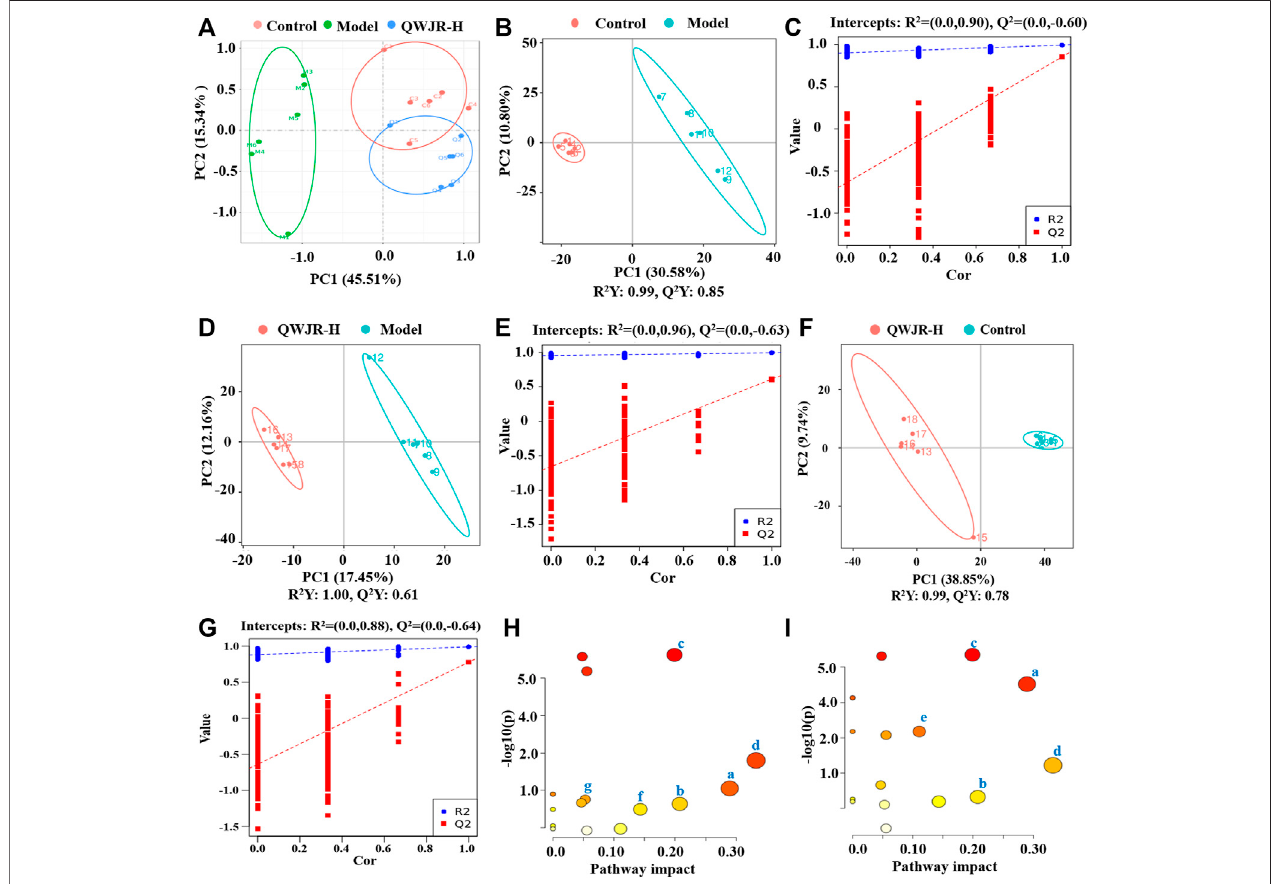
FIGURE 4 | Effect of QWJR on serum metabolite levels in poly(I:C)-induced viral pneumonia rats. (A) Scores plots of PCA between the control and model groups and the model and QWJR-H groups. (B,C) Scores plots of PLS-DA between the control and model groups and the corresponding coef fi cient of loading plots. (D,E) Scoresplots of PLS-DA between the model and QWJR-H groups and thecorresponding coef fi cient ofloading plots. (F,G) Scoresplots of PLS-DA between the control and QWJR-H groups and the correspondingcoef fi cient ofloading plots. (H,I) Summary ofpathway analysis ofserum samples between control and model groups and between model and QWJR-H groups. a: Arginine metabolism; b: Arachidonic acid metabolism; c: Citrate cycle; d: Nicotinate and nicotinamide metabolism; e: Arginine and proline metabolism; f: Tryptophan metabolism; g: Porphyrin and chlorophyll metabolism. Control, model and QWJR-H ( n = 6 per group) groups.